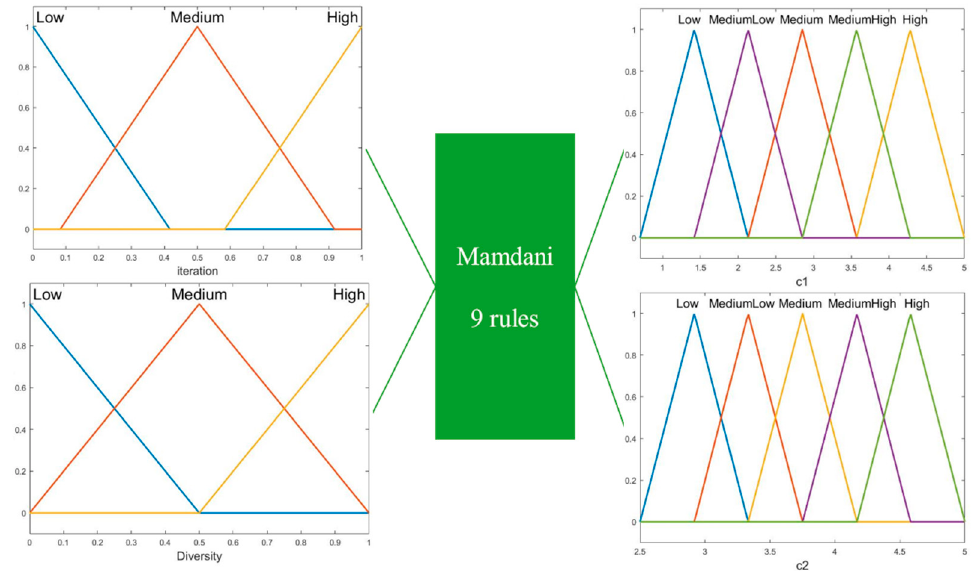
Figure 3. Fuzzy system designed with trapezoidal MFs.